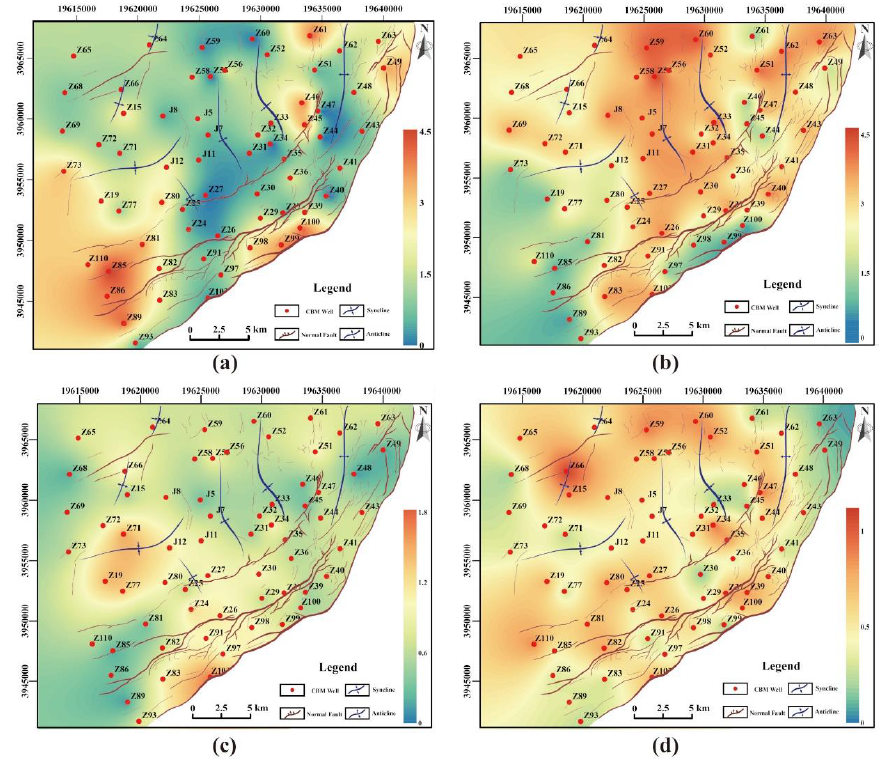
Figure 8. Isopach map of different macrolithotypes of the No. 3 coal seam in the Zhengzhuang field. (( a – d ) represent bright coal, semi-bright coal, semi-dull coal and dull coal). The coal macrolithotypes distribution is controlled by the organic matters input and sedimentary environment, which can be utilized to reconstruct the paleoenvironment of peat swamps [18]. For example, the vitrinite to inertinite ratio (V/I) can intuitively reflects the swamp water cover degree, because typically, vitrinite formed in a relative moist reducing environment coupled with gelatinization, while the inertinite formed in a relative dry oxidizing environment due to the dominating fusainization. In the Zhengzhuang field, the northern, western, and eastern area has V/I values ranging from 1.2 to 2.7, which reflects the moist water covered environments, the central, northeastern, and southwestern area have the V/I ranging from 2.7 to 4 illustrating the moist-deep water covered environments, and the locally southeastern area has the V/I < 1 reflecting dry shallow water covered environment. Corresponding to the distributions of the coal macrolithotypes (Figure 9), bright coal and semi-bright coal are formed in the moist-deep water covered and moist water covered environments respectively, and semi-dull coal and dull coal are usually formed in the dry shallow water covered